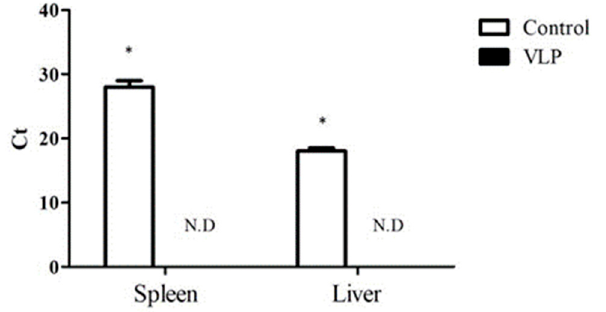
Figure 4. Viral load in the spleen and liver of pigeons. Pigeons from the control group and the PiCV rCap-VLPs immunized were challenged with lymphoid tissues that have 6 × 10 3.5 copies/g of PiCV. Following immunization and challenge, viral loads in the lymphoid organs of the pigeons were quantified by qPCR and the data are presented as Ct. Significant difference ( p < 0.05) was notated as *. ND means not detected.